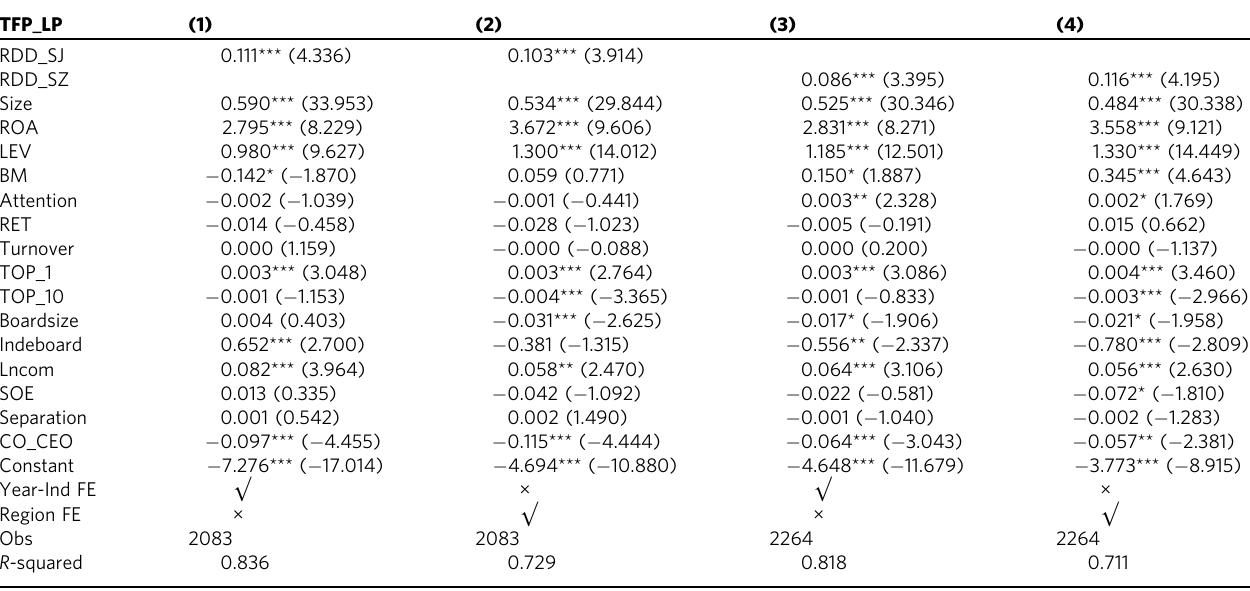
Table 5 Regression discontinuity design.